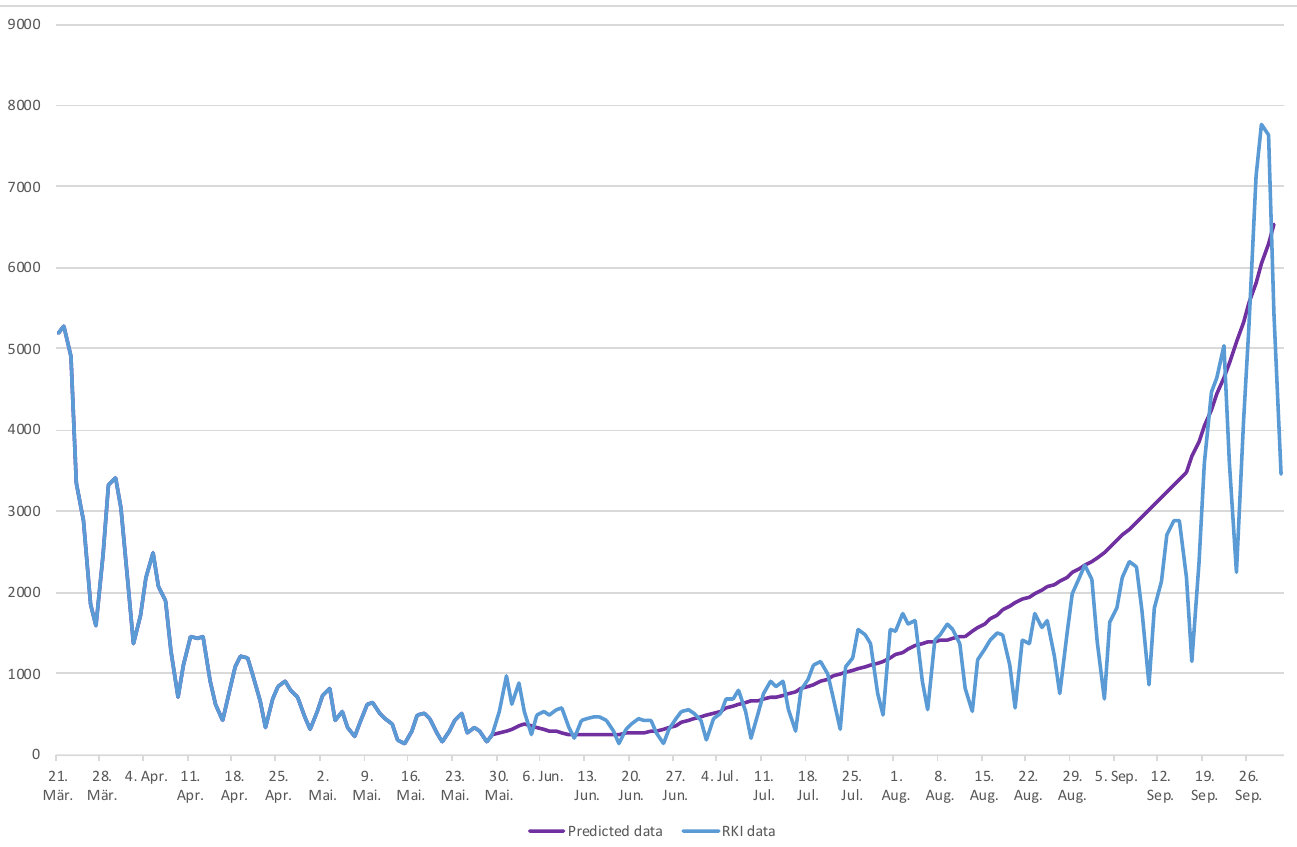
Figure 9. Predicted number of infections in Germany versus real data from